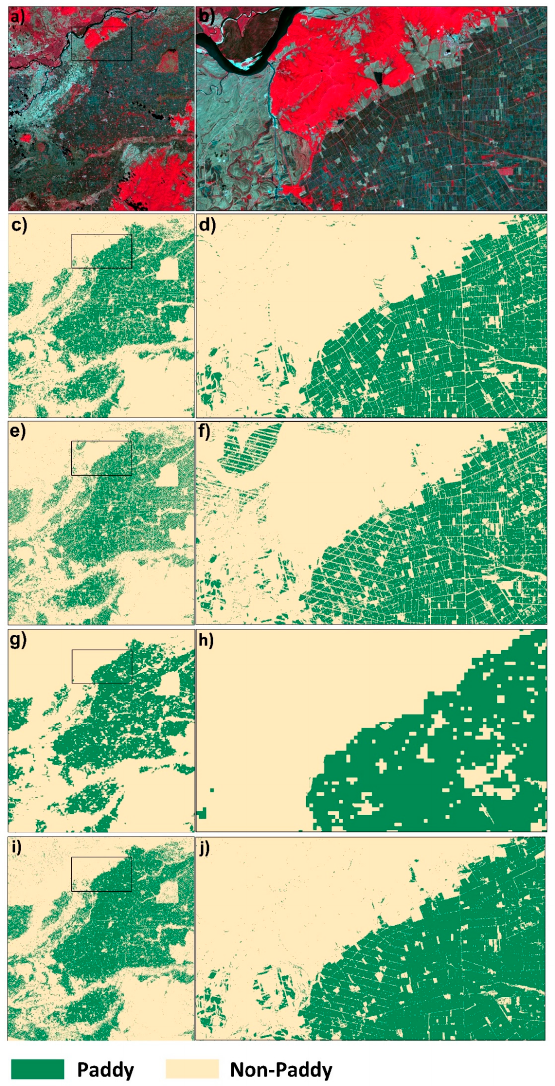
Figure 13. The comparison of four paddy rice maps: ( a ) Landsat image (false color composite, include red band, green band and blue band); ( c ) fusion-based paddy rice map, and ( e ) Landsat-based paddy rice map; ( g ) MODIS-based paddy rice map; ( i ) RF-based paddy rice map. ( b , d , f , h , j ) display the spatial details of ( a , c , e , g , i ) respectively within the black box.